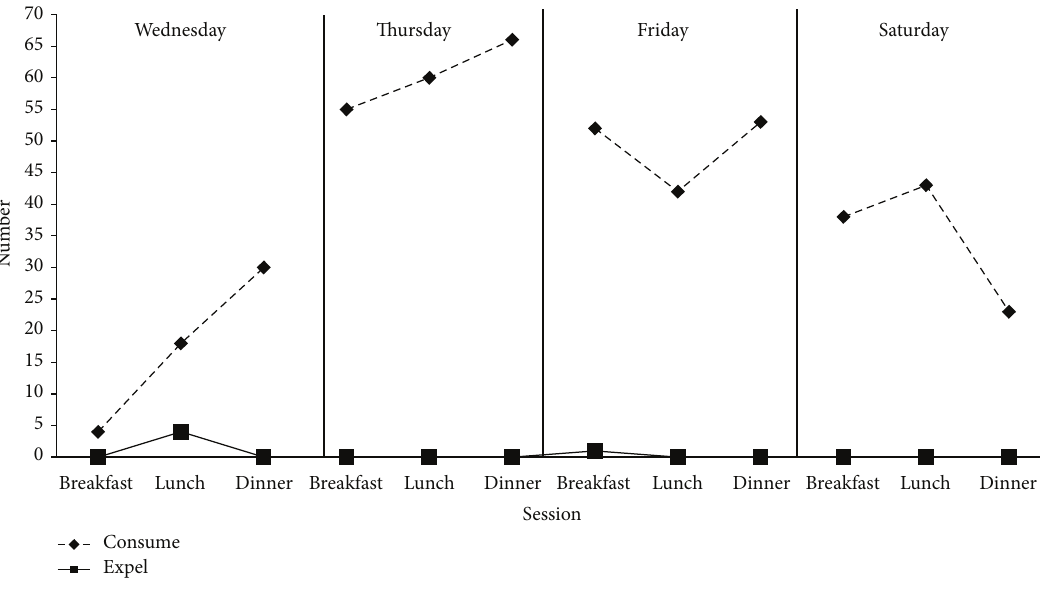
Figure 1: Total bites consumed and expelled.